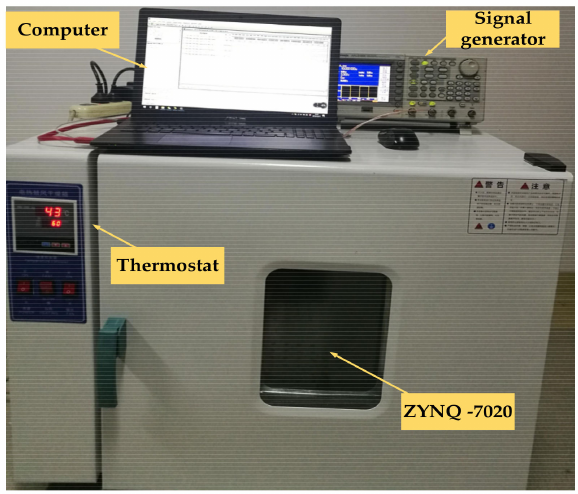
Figure 7. Experimental setup of the proposed FPGA-TDC measure system.